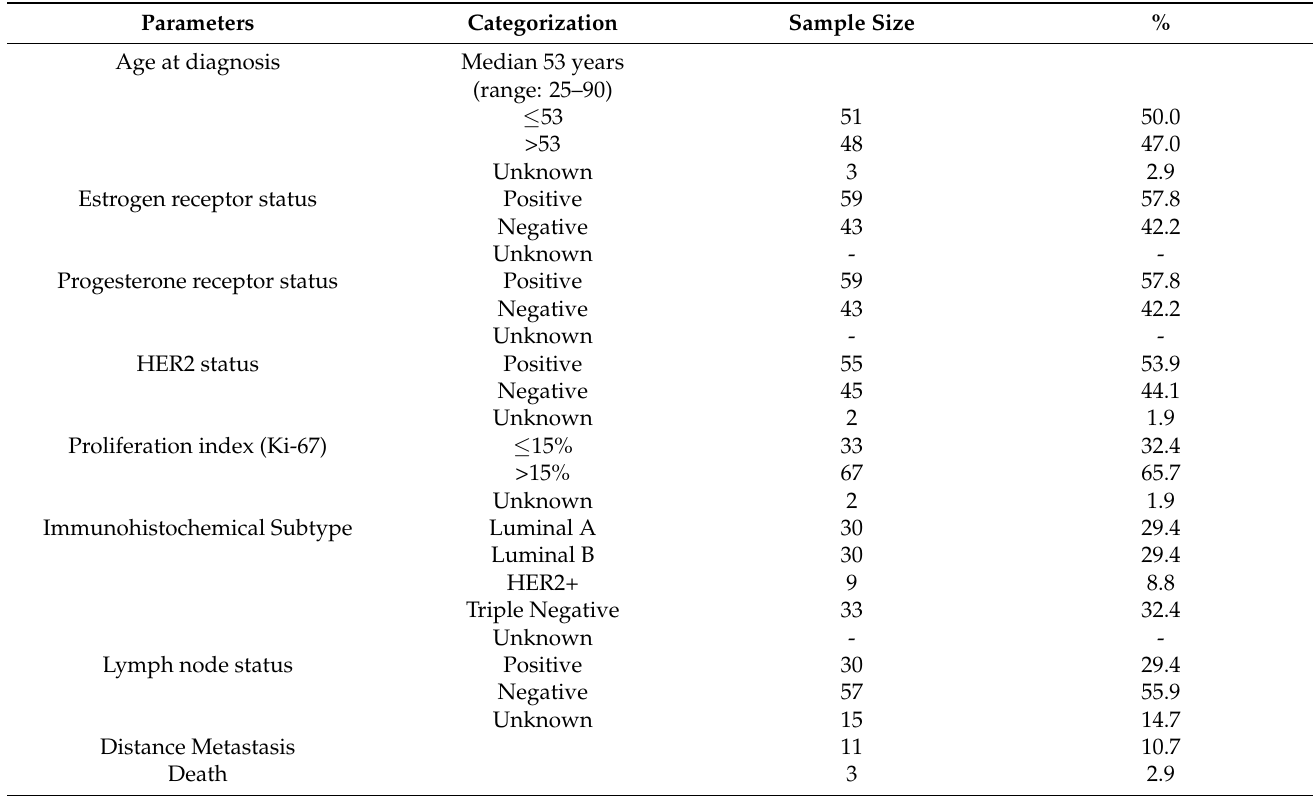
Table 1. Clinicopathological parameters of Brazilian breast cancer